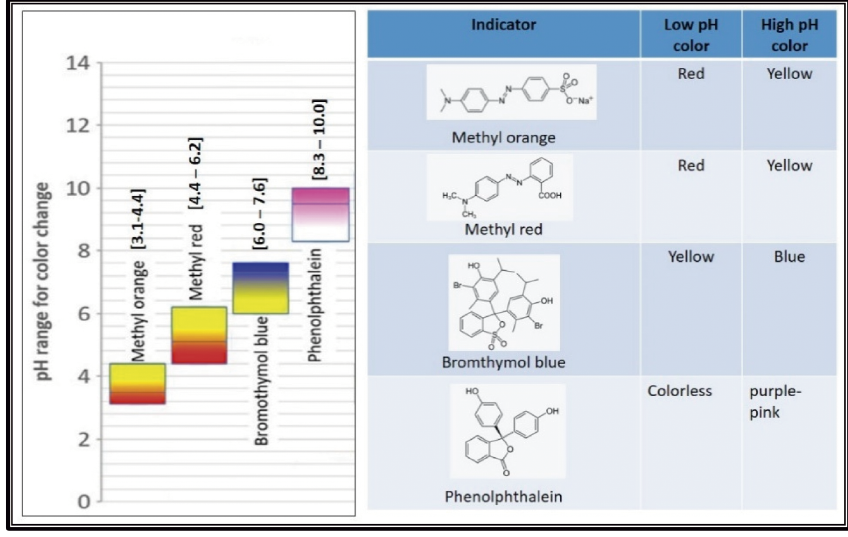
Figure 4. The color change phenomenon in each pH